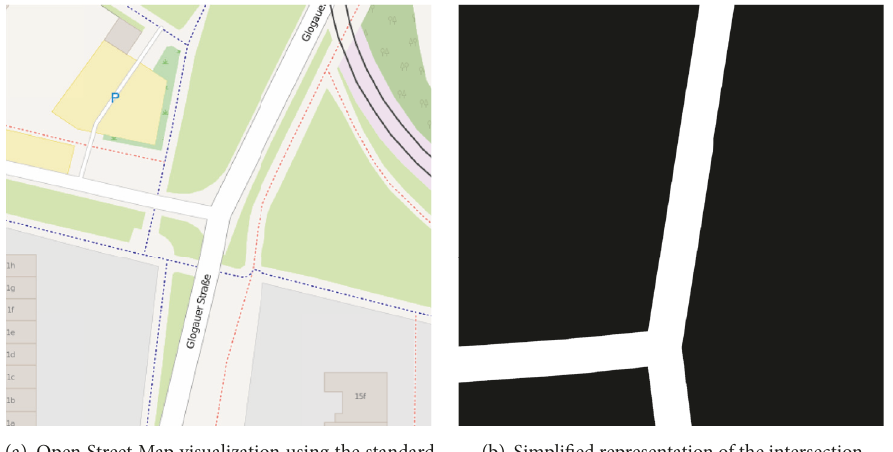
Figure 13: Standard layer map and line segment representation of an intersection. The orientation of the map is aligned with the vehicle orientation and the road width is estimated using the method presented in Section